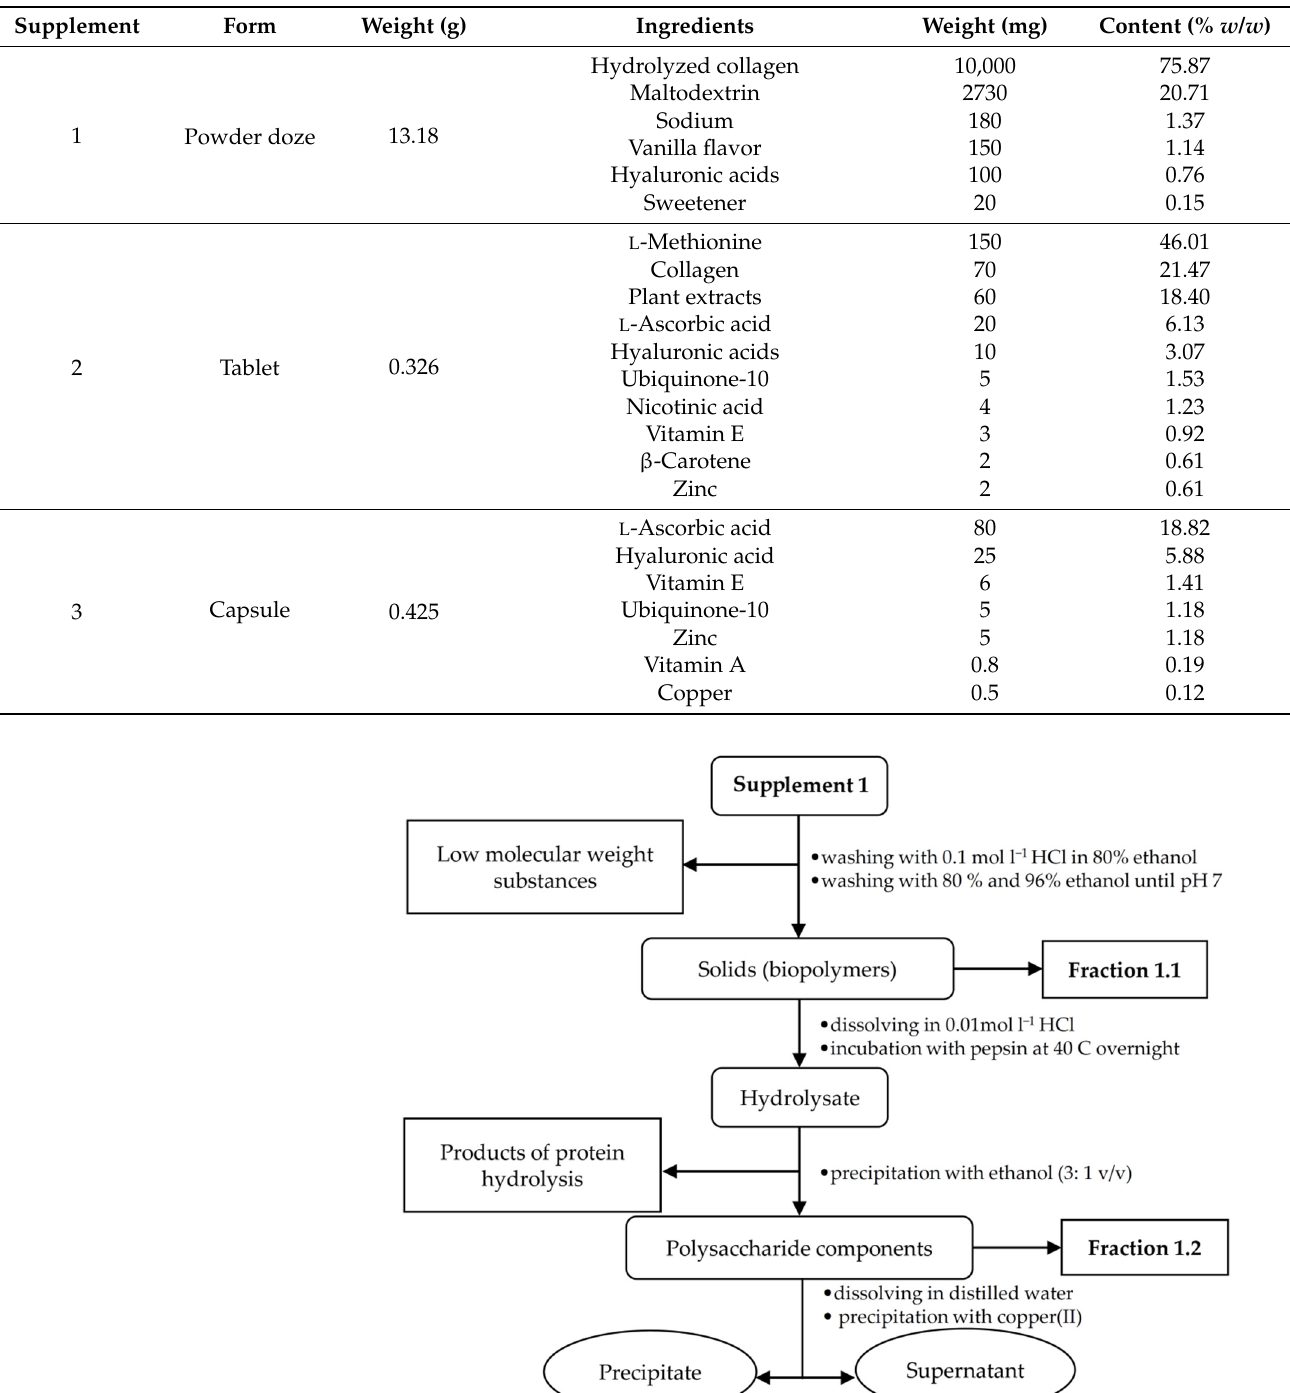
Table 1. Composition of food supplements 1–3 declared by manufacturers.